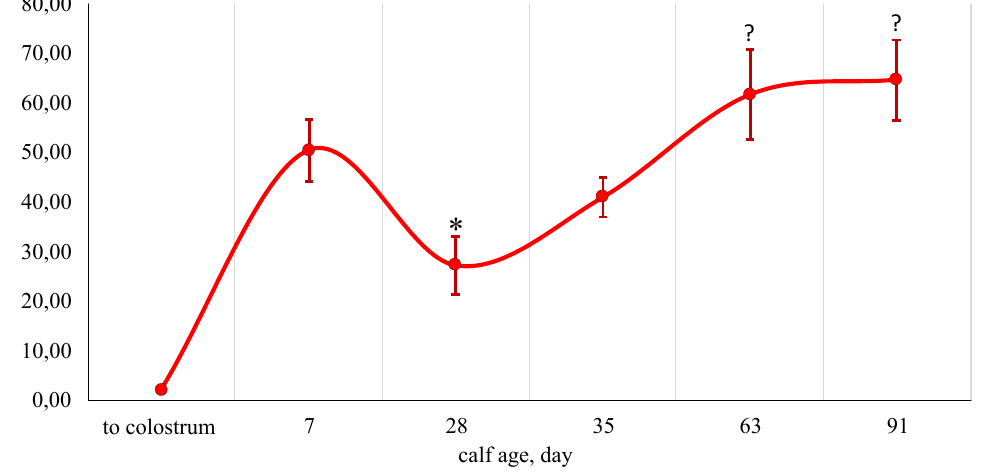
Fig. 1. Level of total IgG in blood serum of calves (M ± m, g/dm 3 , n =